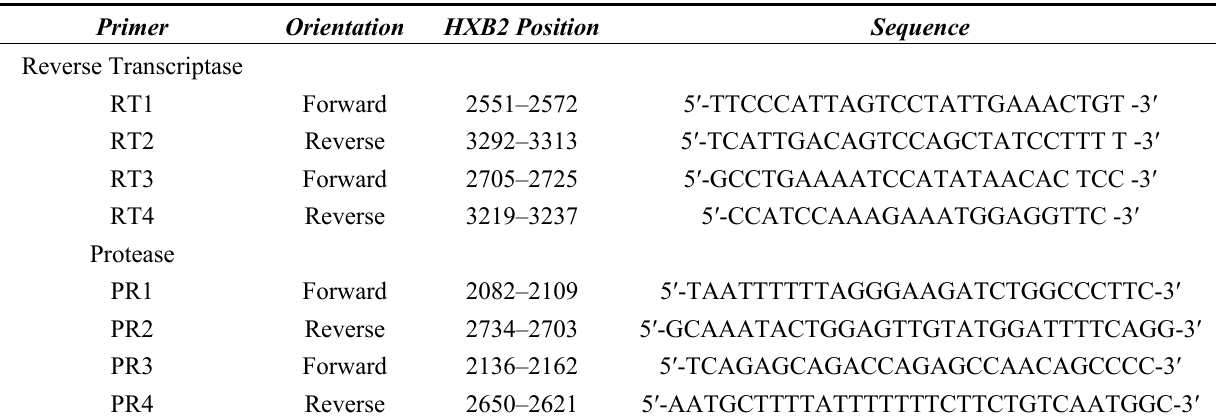
Table 1. List of primers for amplification of RT and PR gene.